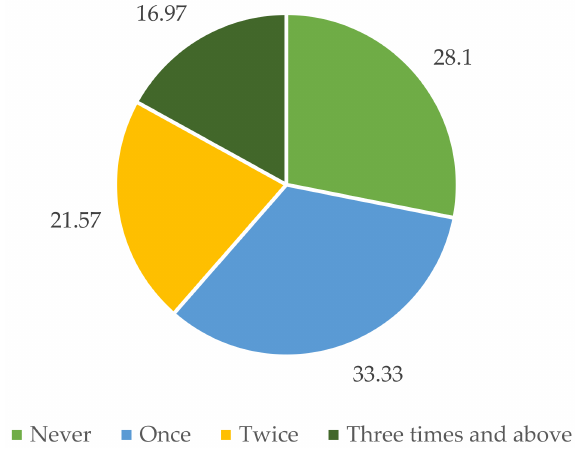
Figure 1. Practice of abortion in five survey locations